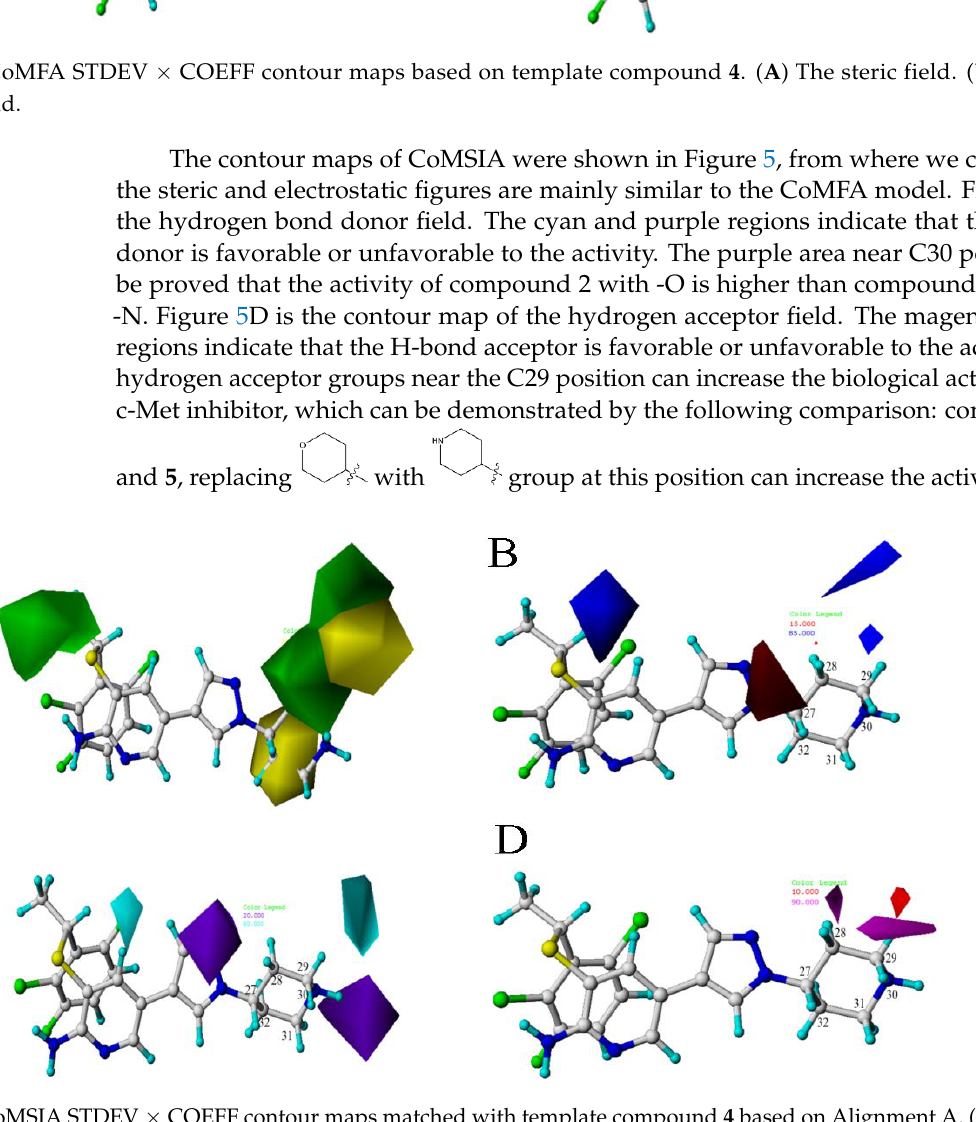
Figure 5. The CoMSIA STDEV × COEFF contour maps matched with template compound 4 based on Alignment A. ( A ) The steric field. ( B ) The electrostatic field. ( C ) The hydrogen bond donor field. ( D ) The hydrogen bond acceptor field.